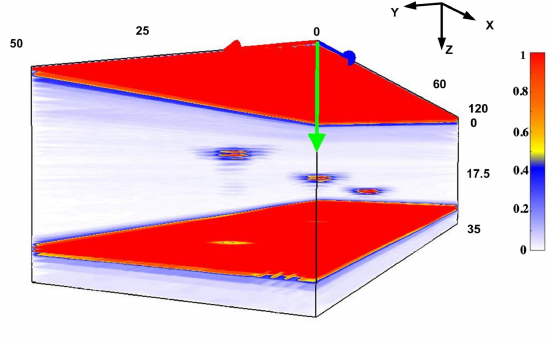
Figure 8. Example of obtained volumetric